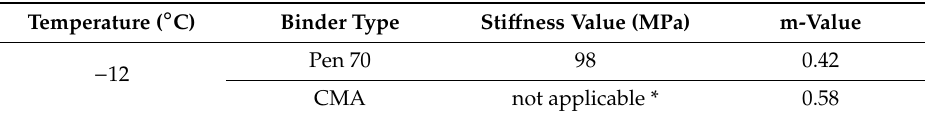
Table 3. Results of BBR test